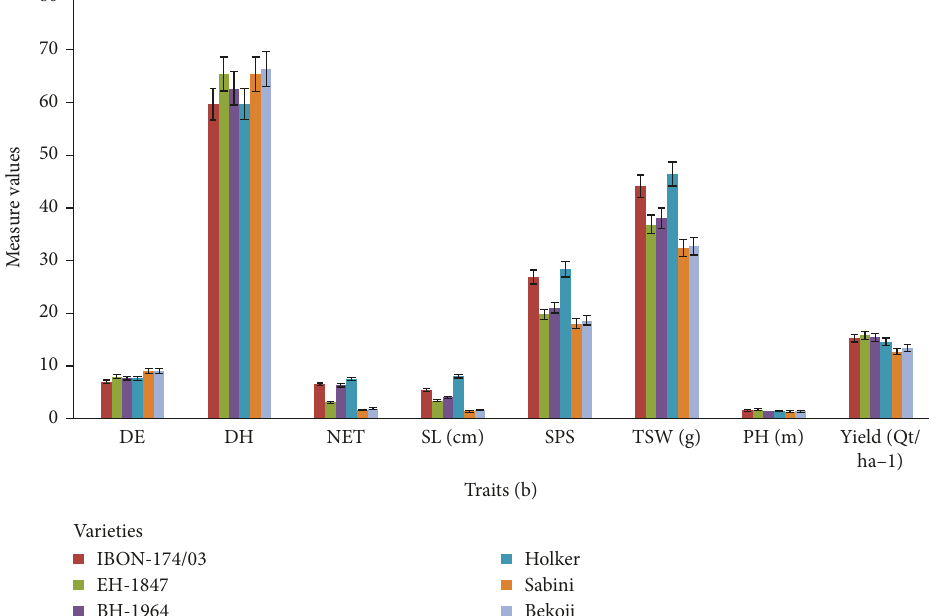
Figure 7: Mean performance of malt barley varieties in 2020 cropping season. DE � days to an emergency, DH � days to heading, NET � number of effective tillers per plant, SL � spike length, PH � plant height, SPS � seeds per spike, and TSW � thousand seed